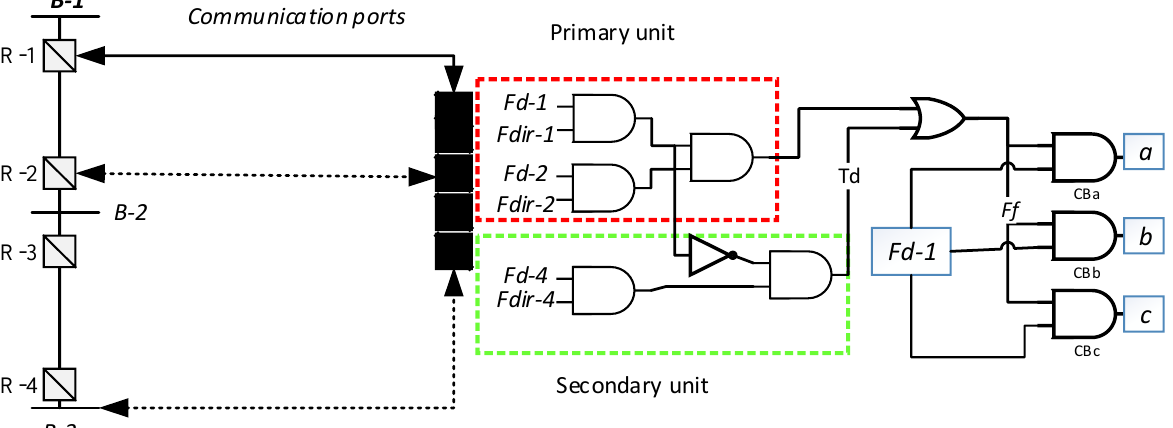
Figure 4. Communication-assisted relay logic design, where a, b, and c represented the phases.